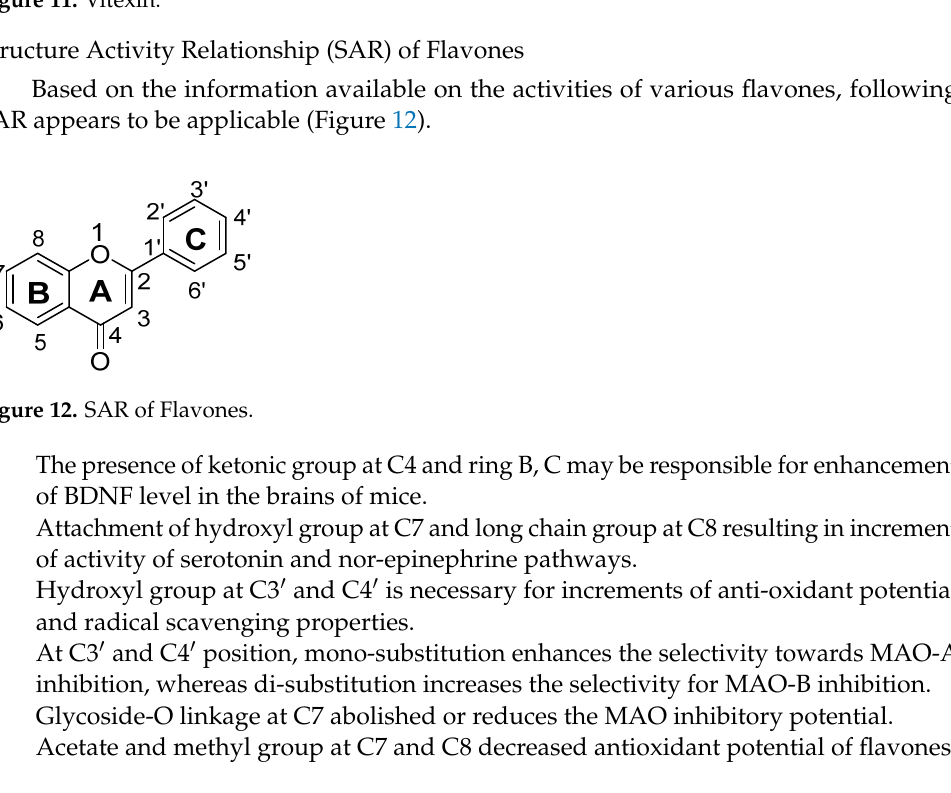
Figure 11. Vitexin. Figure 11. Vitexin.